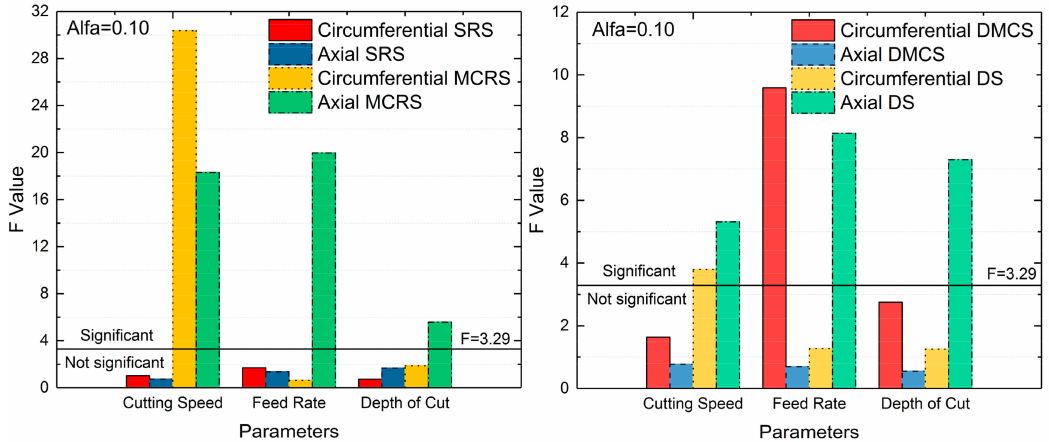
Figure 10. The e ff ects of the cutting parameters on residual stress distribution